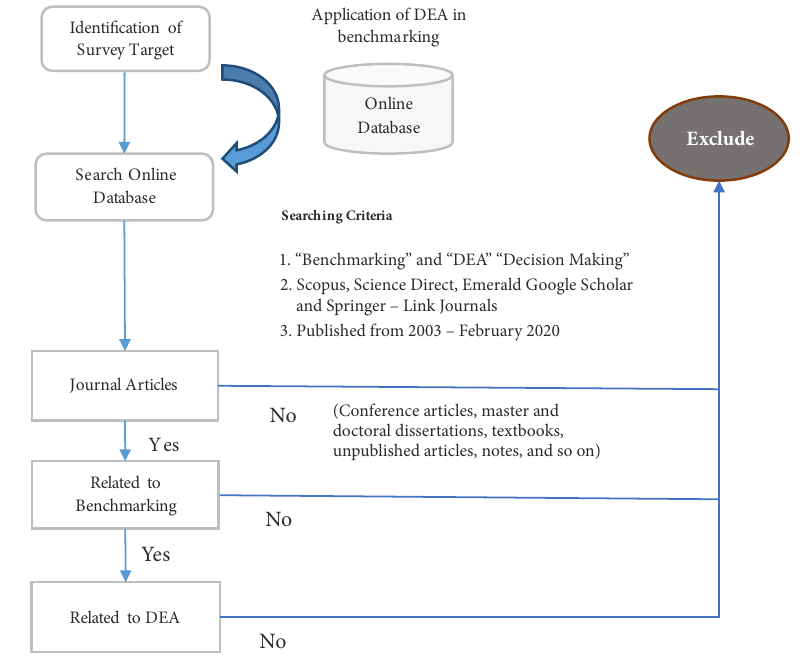
Figure 2. Research methodology of this